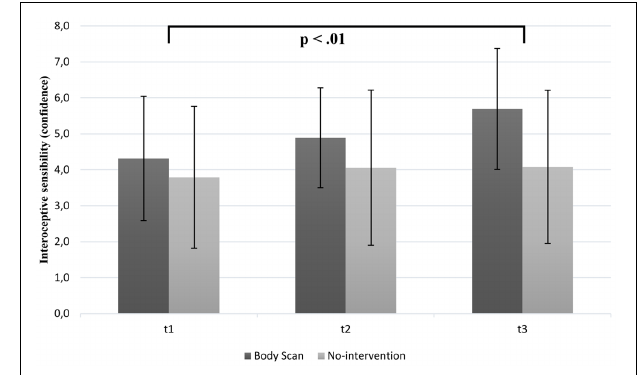
FIGURE 4 | Mean confidence ratings as a function of group (BS vs. inactive group) and time (note: significant group differences at all time points are not marked